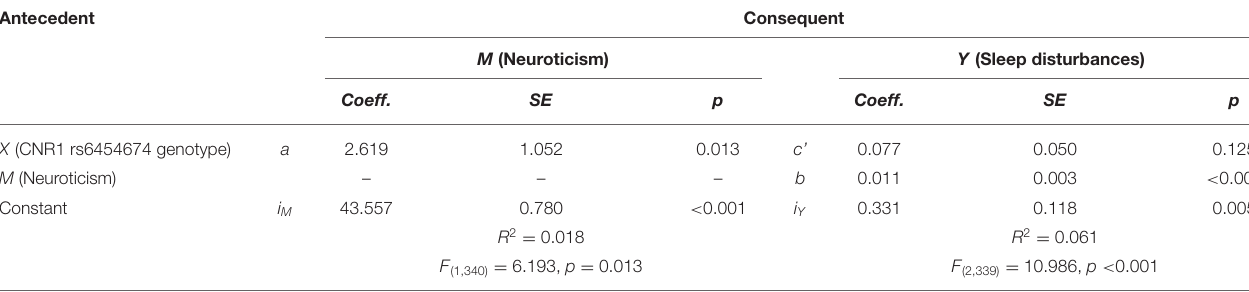
TABLE 3 | Model coefficients for neuroticism mediation. Antecedent Consequent M (Neuroticism) Coeff.